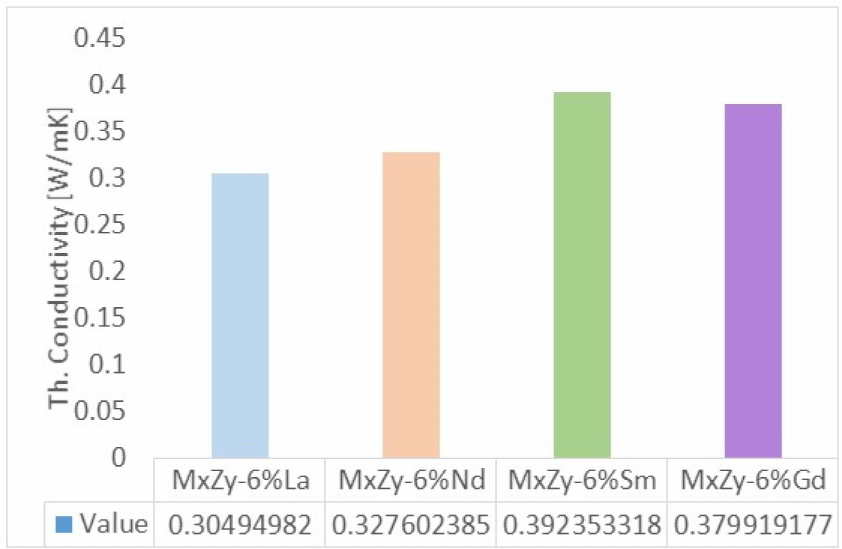
Figure 6. Thermal conductivity for ZrO 2 co-doped with 8 wt.% Y-6% Ln (Ln = La, Nd, Sm, Gd).